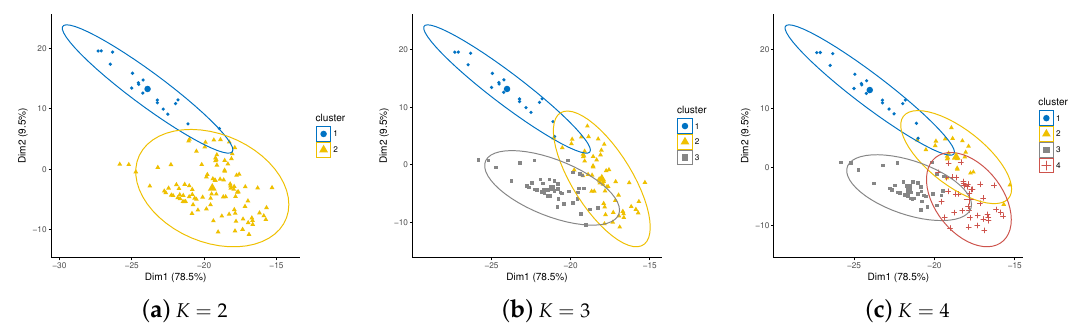
Figure 3. K-means clustering on SFD-out data, when K takes different optimal values. Cluster plot is visualized using the factoextra package in R, where X-axis and Y-axis represent principal axes and their variable contributions.